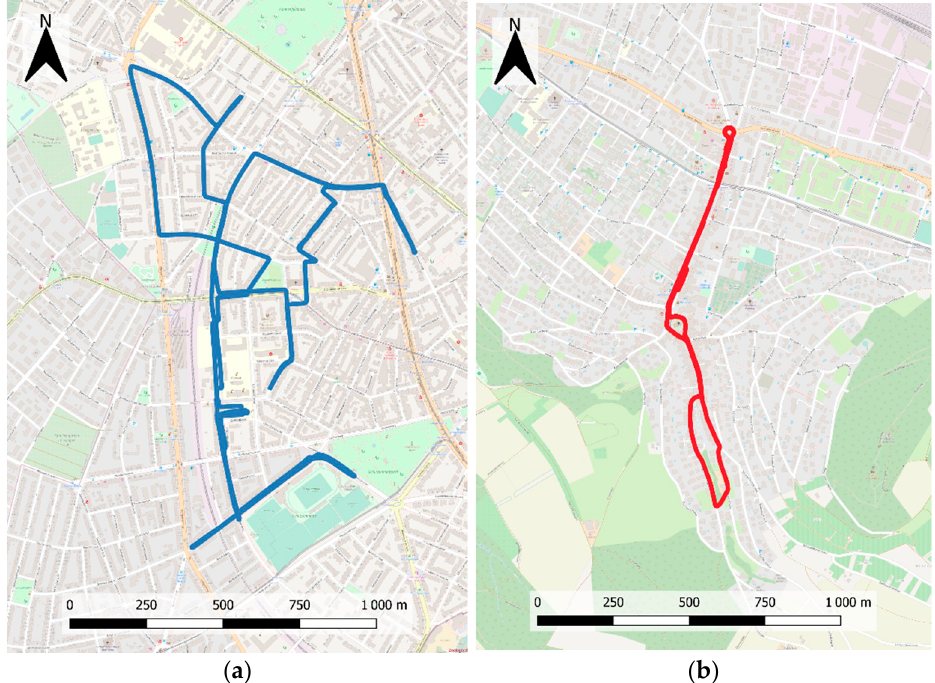
Figure 8. Maps showing the mobile measurement campaigns conducted in the area of Basel, Swit- zerland: ( a ) Basel city, 11 December 2020, ( b ) Muttenz, 3 April 2021. Background map: © OpenStreetMap contributors.